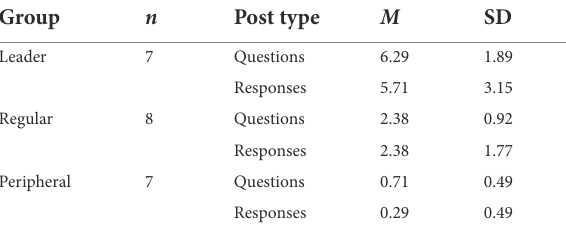
TABLE 8 Means and standard deviations of systems thinking scores by participation group and post